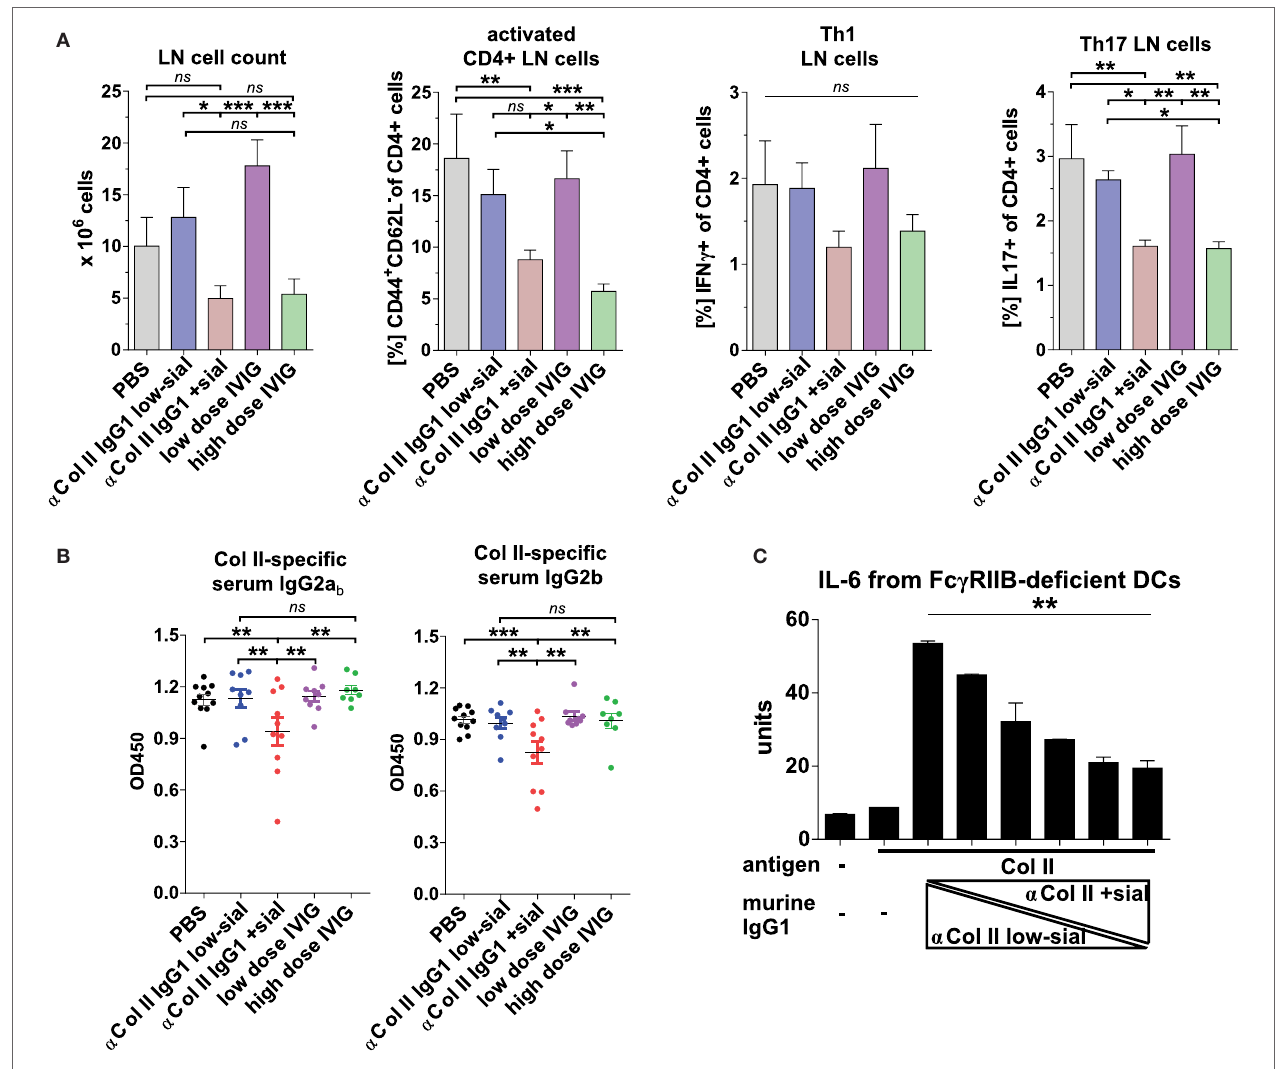
FigUre 6 | Sialylated collagen type II (Col II)-reactive monoclonal IgG antibodies (Abs) reduce the accumulation of proinflammatory Th17 cells and IgG autoAbs. Collagen-induced arthritis (CIA) was induced in Fcgr2b − / − mice as described in Figure 5 and Figure S5C in Supplementary Material. One day before and 9